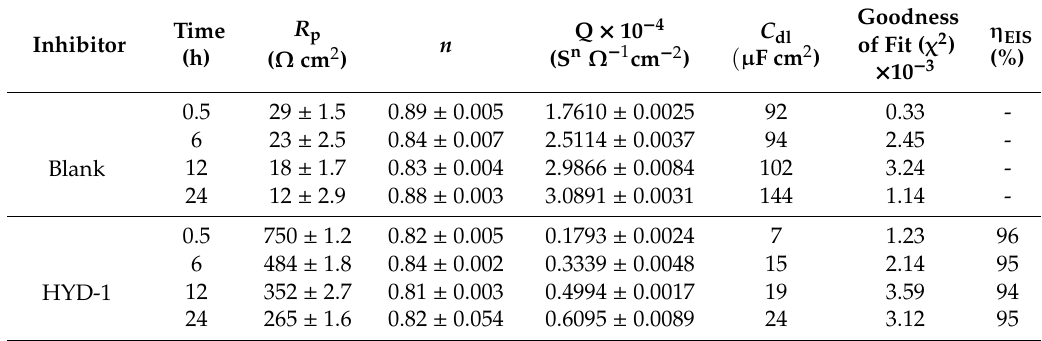
Table 5. EIS parameters for mild steel in the absence and presence of HYD-1 at various times.